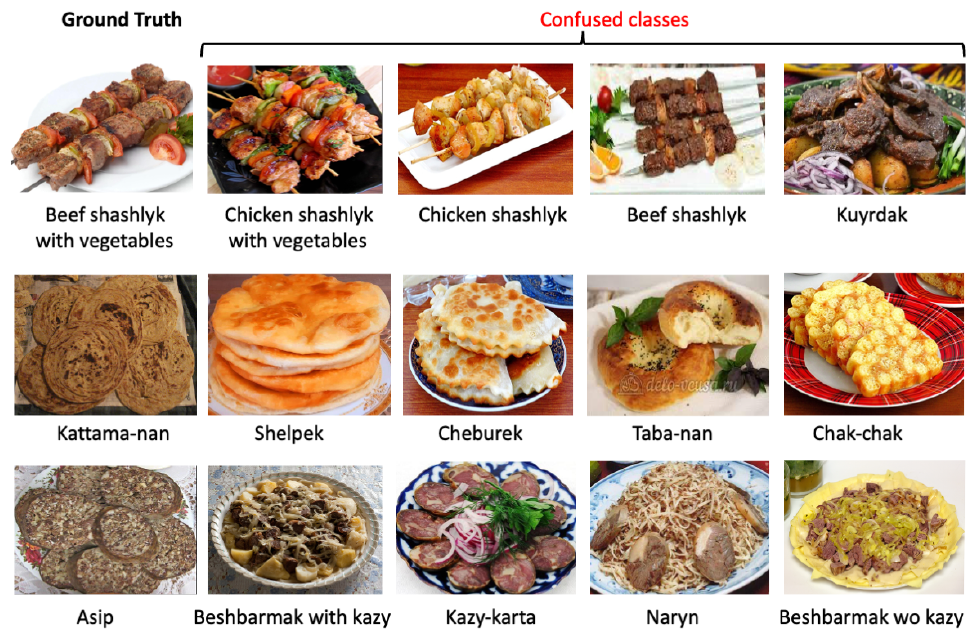
Figure 4. Examples of the confused